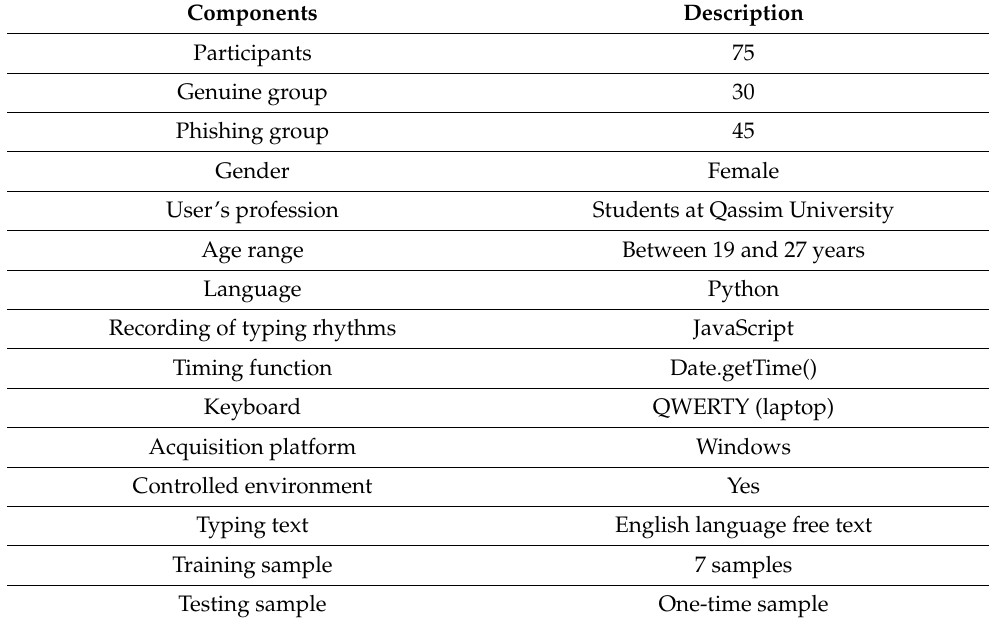
Table 2. Components of the proposed system .